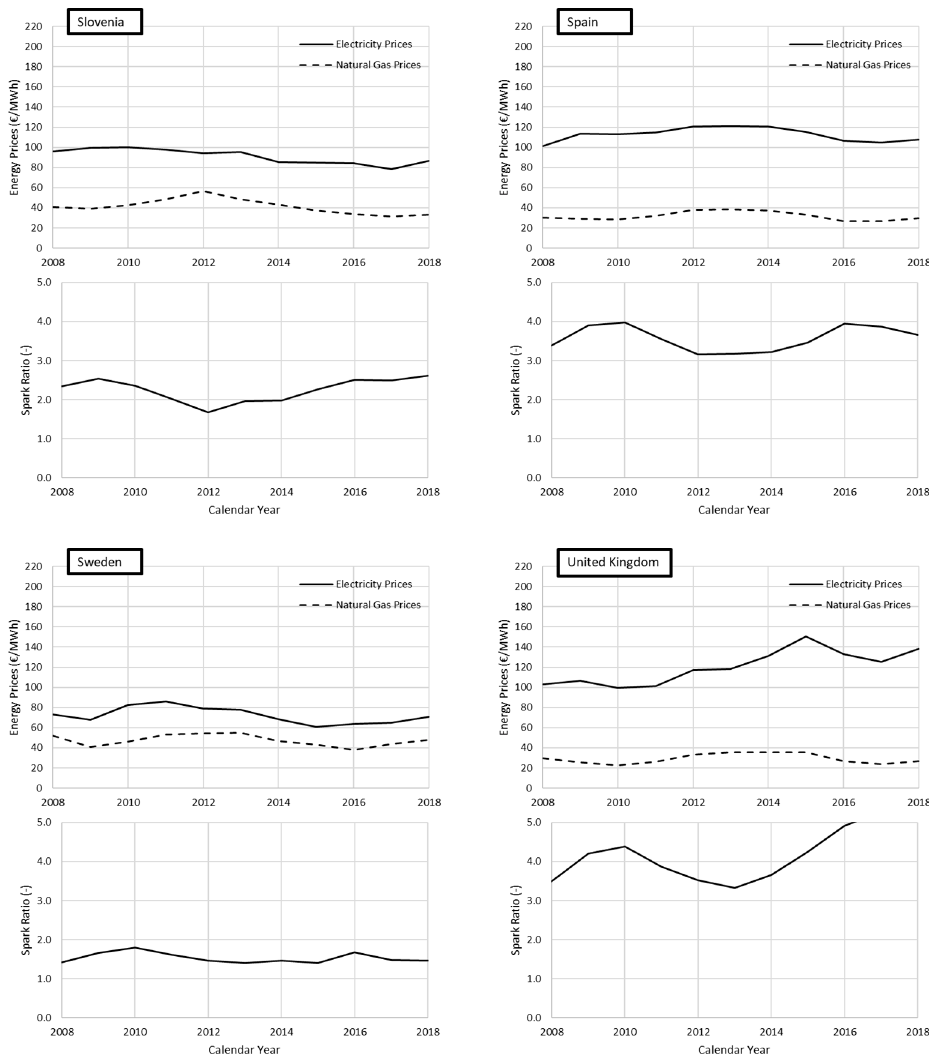
Figure A1. Evolution of European countries energy prices and spark ratio during 2008–2018.